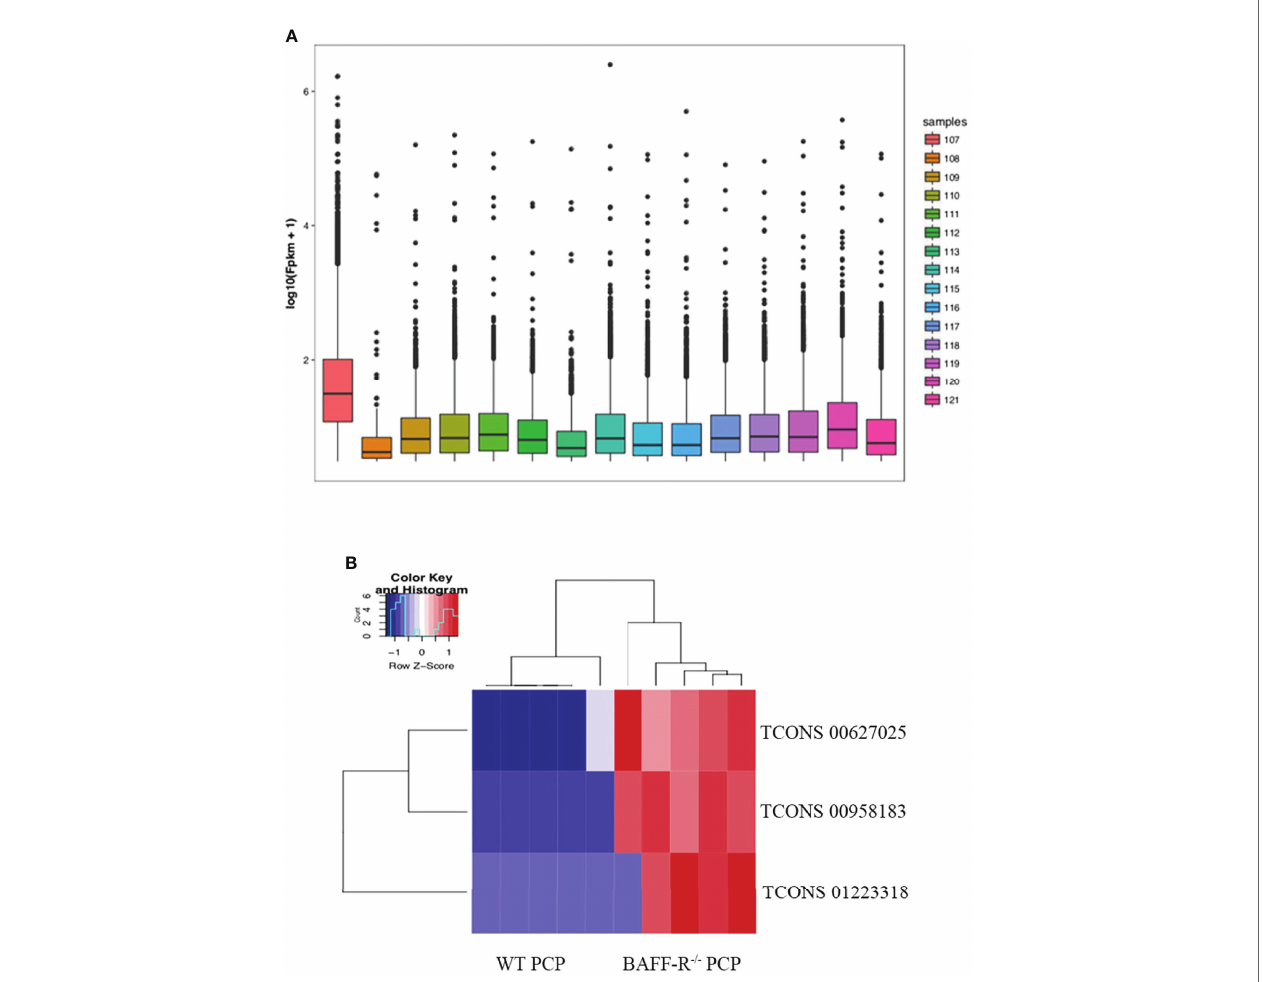
FIGURE 2 | New transcription area and novel lncRNA and in BAFF-R – / – PCP mice. (A) Analysis of a new transcription area in the control group, WT PCP group and BAFF-R – / – PCP group. Boxplot uses the minimum, fi rst quartile, median, third quartile, and maximum value of a set of data to re fl ect the central position and walking range of data distribution, which can roughly judge whether the data are symmetric or not. (B) Heat map demonstrates that compared with the WT PCP group, there were 3 novel lncRNAs increased in the BAFF-R – / – PCP group.